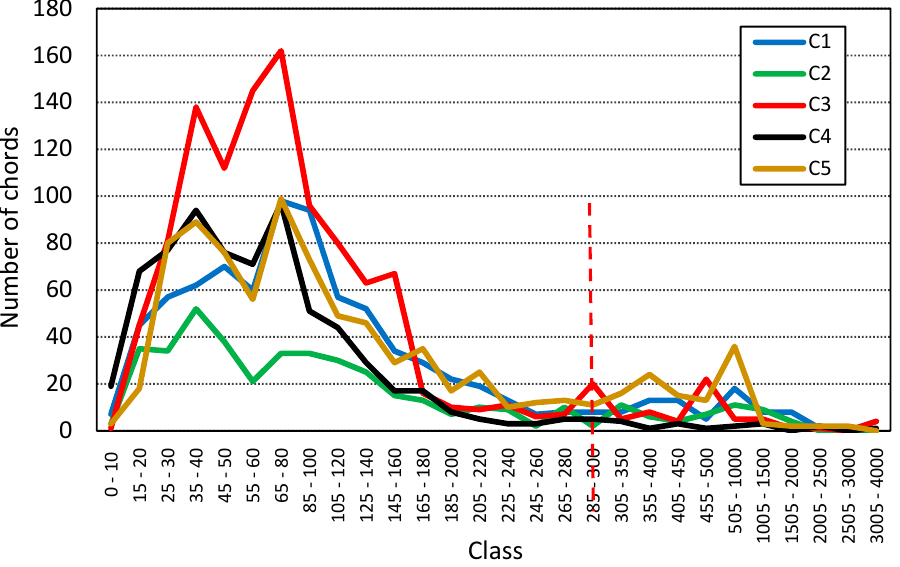
Figure 4. Chord length distribution by class for C1–C5 concretes.